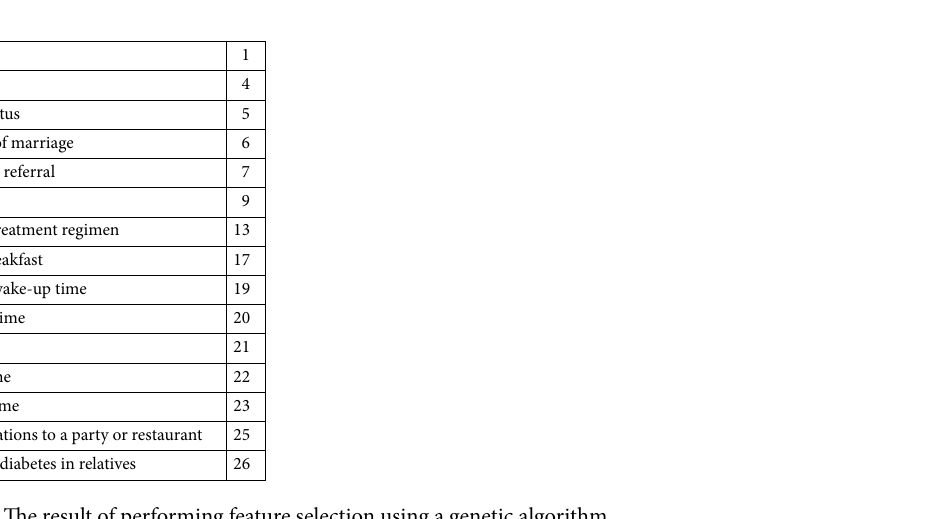
Table 4. The result of performing feature selection using a genetic